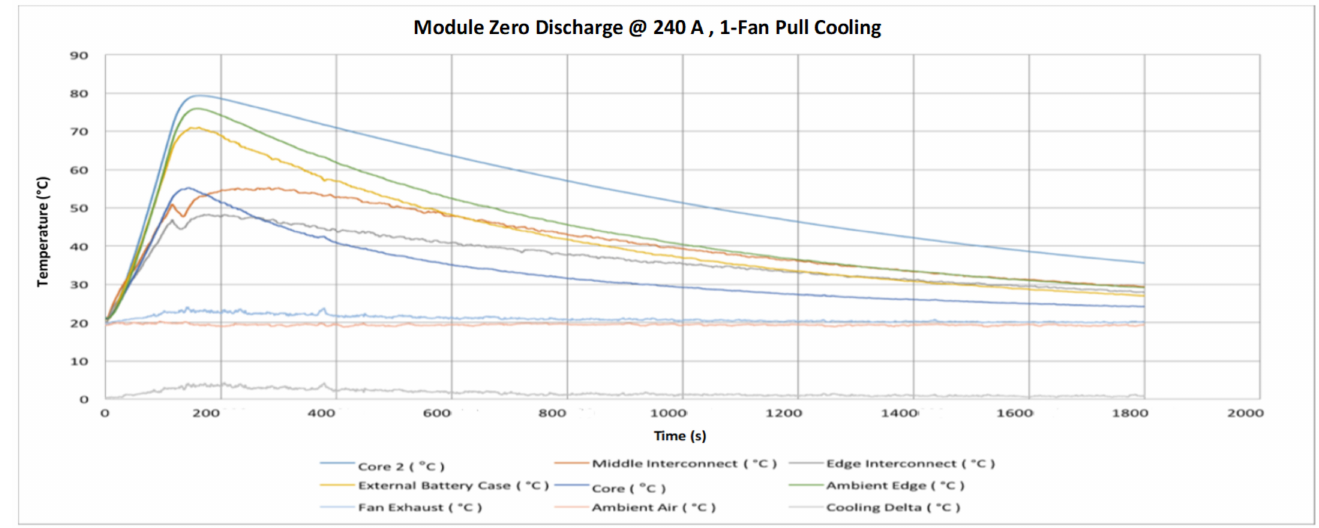
Figure 18. Module zero discharge, 240 A 1-fan pull